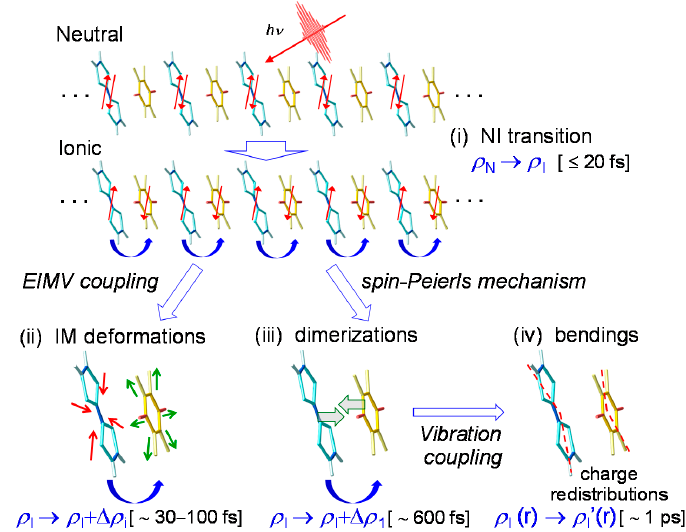
Figure 16. Schematic of photoinduced N -to- I transition dynamics in TTF-CA [30]. Blue curved arrows indicate electron transfers.